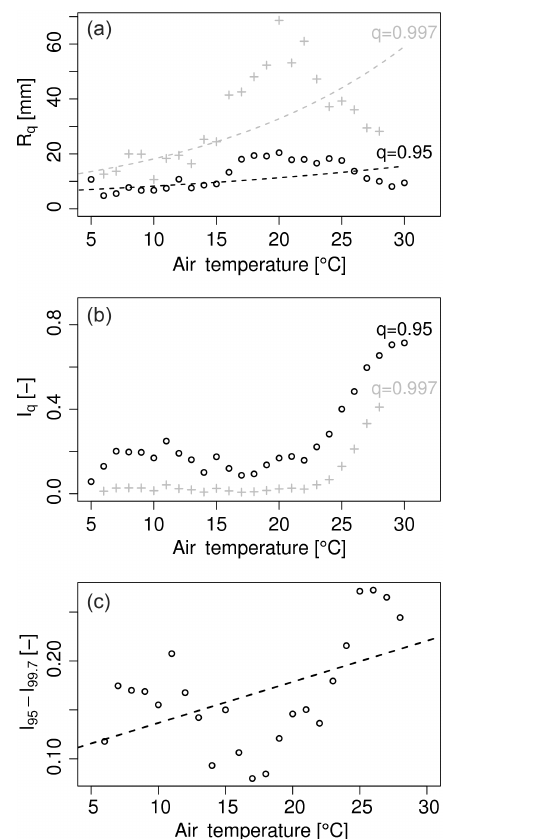
Figure 12. From (a) to (c) : rainfall quantiles, internal intermittency and changes in intermittency at the hourly timescale as a function of temperature and two different quantiles ( q = 0.95 and q = 0.997) for the station AL-Fairhope-3-NE. The dashed line in (c) represents the fitted linear regression (using least squares) of I 95 – I 99 . 7 as a function of air